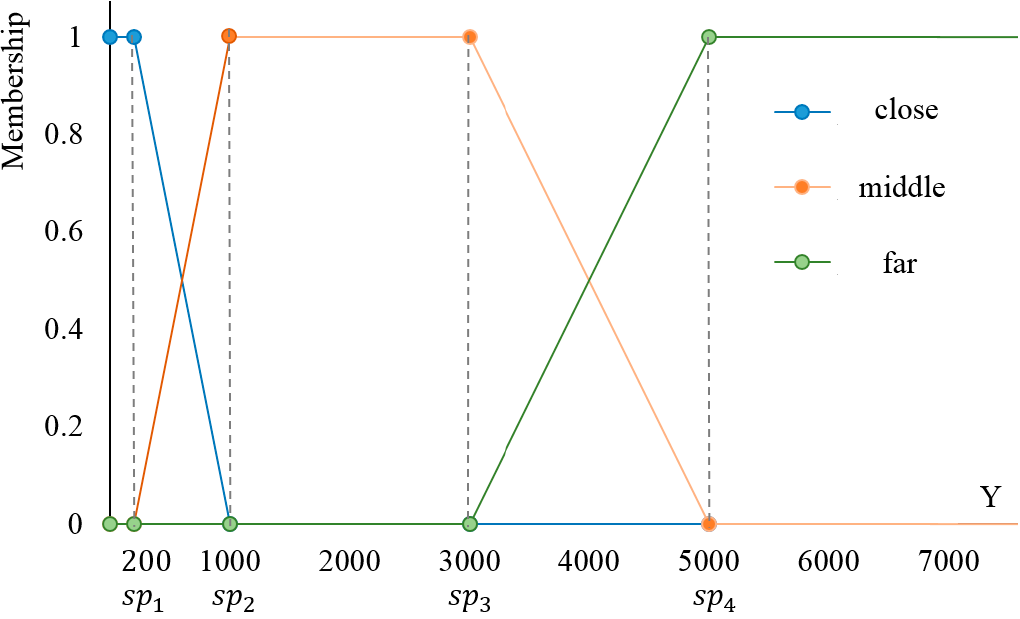
Figure 2. The graphs of membership functions (Equations (1)–(3)) of terms close , middle , and far .